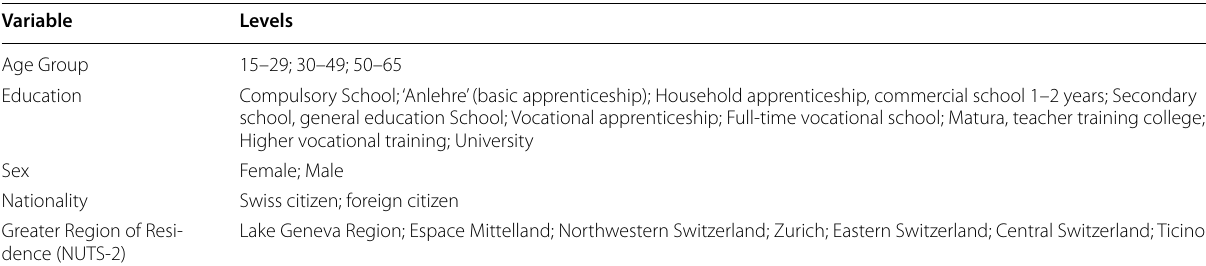
Table 7 Control Variables and Levels